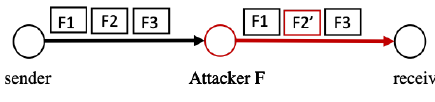
Figure 6. Alteration